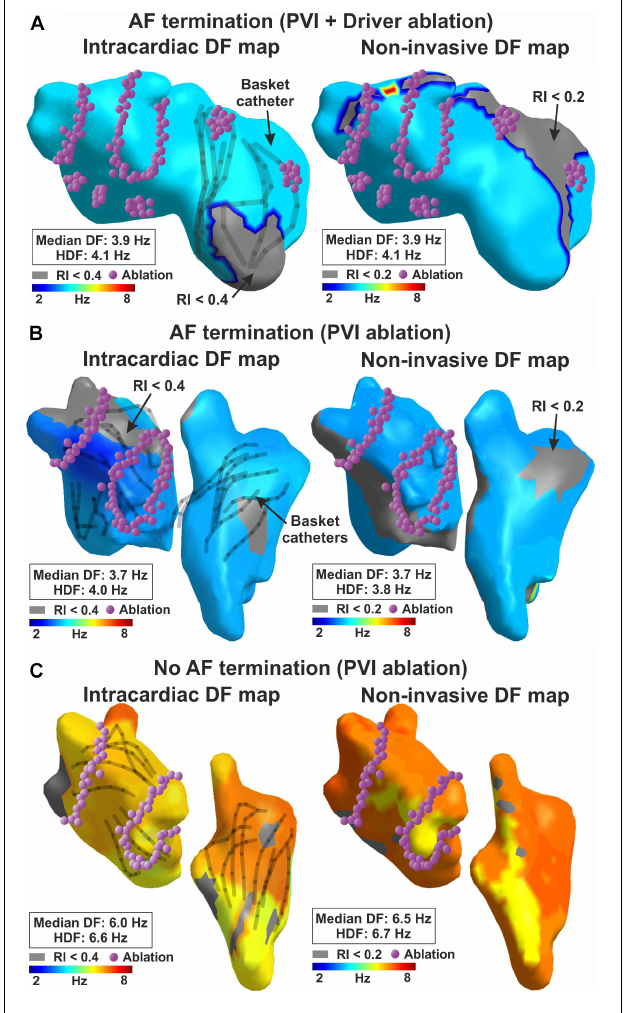
FIGURE 4 | Dominant frequency maps and acute AF termination. Intracardiac (left) and non-invasive (right) DF map for (A) a patient with acute AF termination during guided ablation; (B) a patient with acute AF termination during PVI ablation; (C) no acute AF termination during PVI ablation.